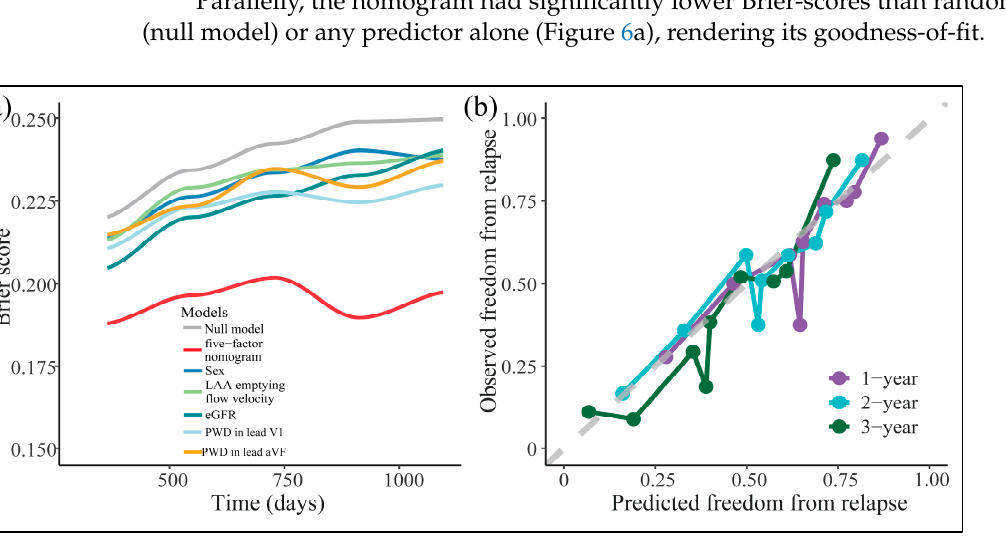
Figure 6. Time-dependent Brier score curves ( a ) and calibration plots ( b ) across 1, 2, and 3 years after ablation.